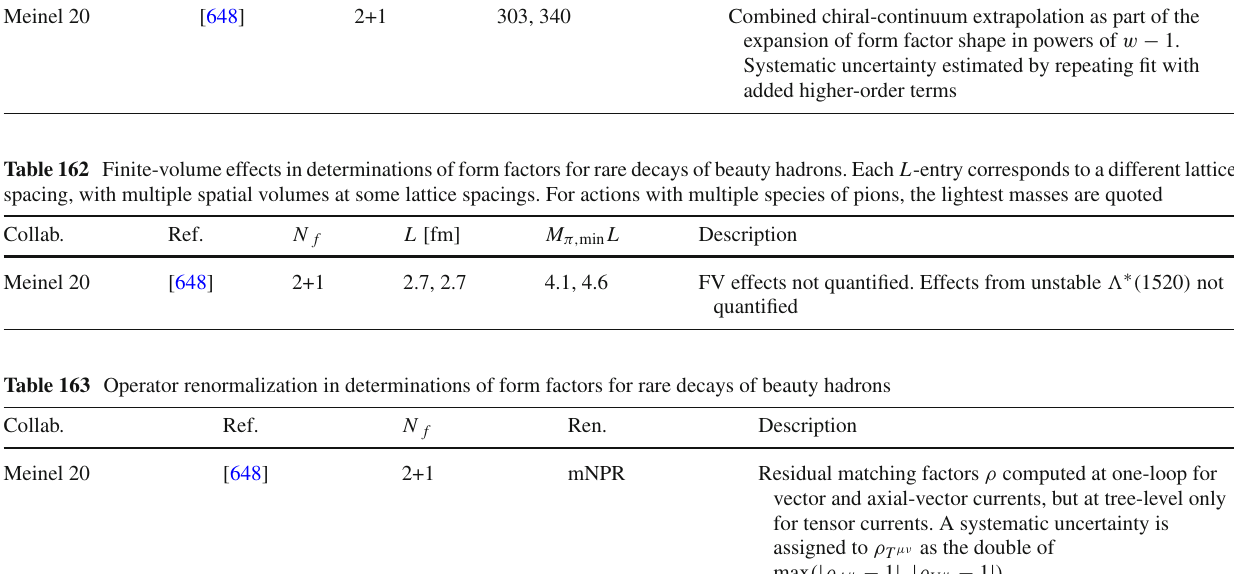
Table 161 Chiral extrapolation/minimum pion mass in determinations of form factors for rare decays of beauty hadrons. For actions with multiple species of pions, masses quoted are the RMS pion masses. The different M π, min entries correspond to the different lattice spacings Collab.